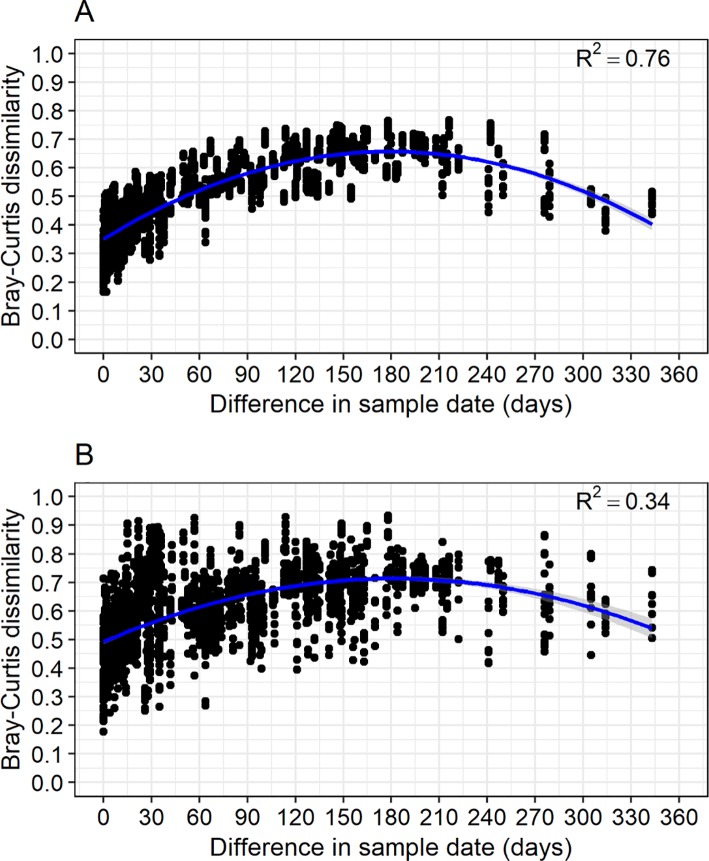
Temporal patterns in bacterioplankton beta diversity measured using Bray-Curtis dissimilarity.Relationships between (A) particle-associated and (B) free-living dissimilarities and interval of time between sample dates. Points represent pairwise dissimilarities calculated from bacterioplankton assemblages collected between 1 and 343 days apart.